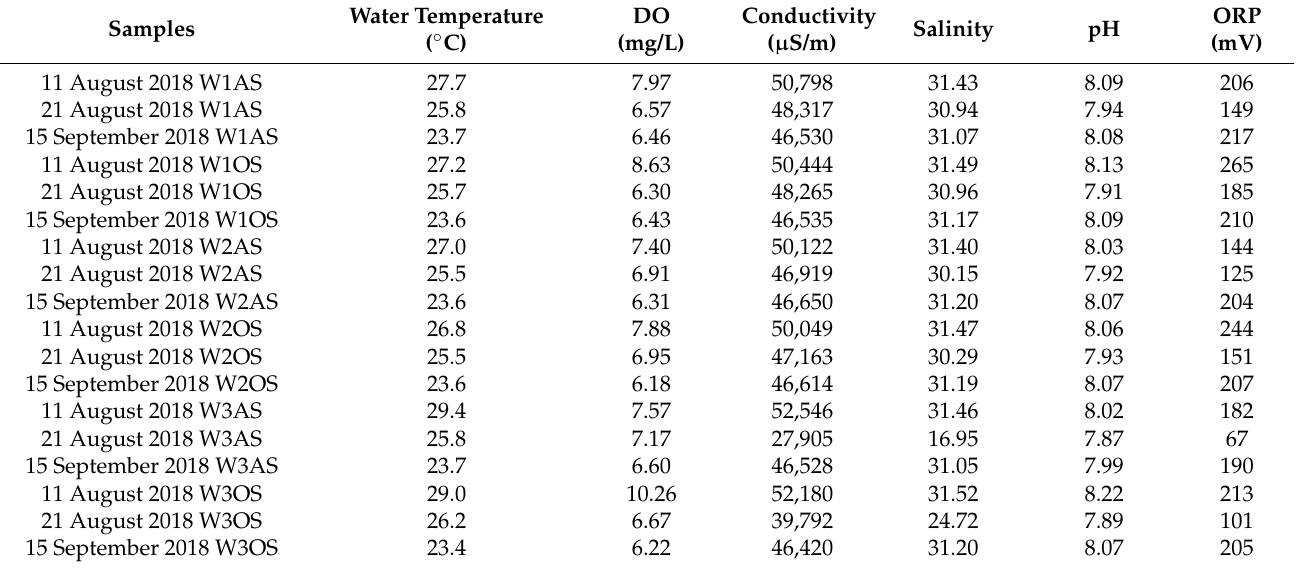
Table 1. Water quality parameters and bacterial concentration of alongshore